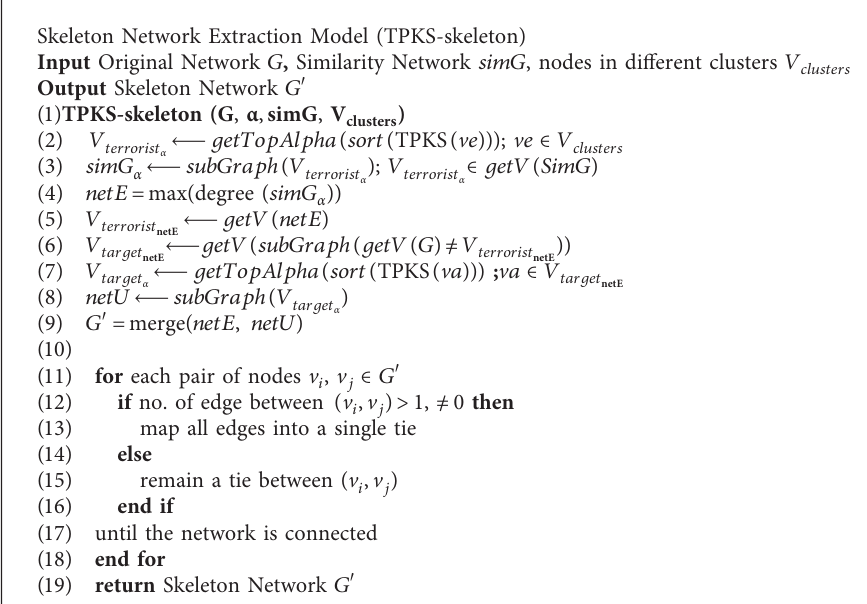
Skeleton Network Extraction Model